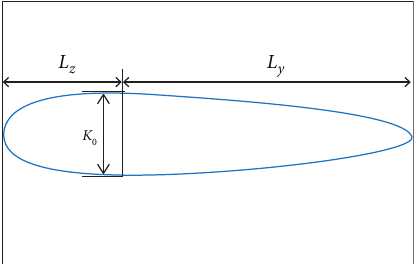
Figure 2: Top view of sandcastle